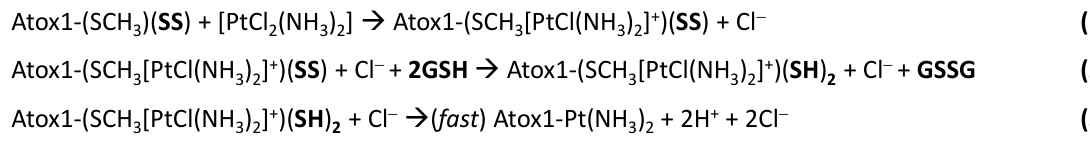
Scheme 1. Possible reaction mechanism of oxidized Atox1 with cisplatin and cleavage of disulfide bond in the presence of reduced glutathione